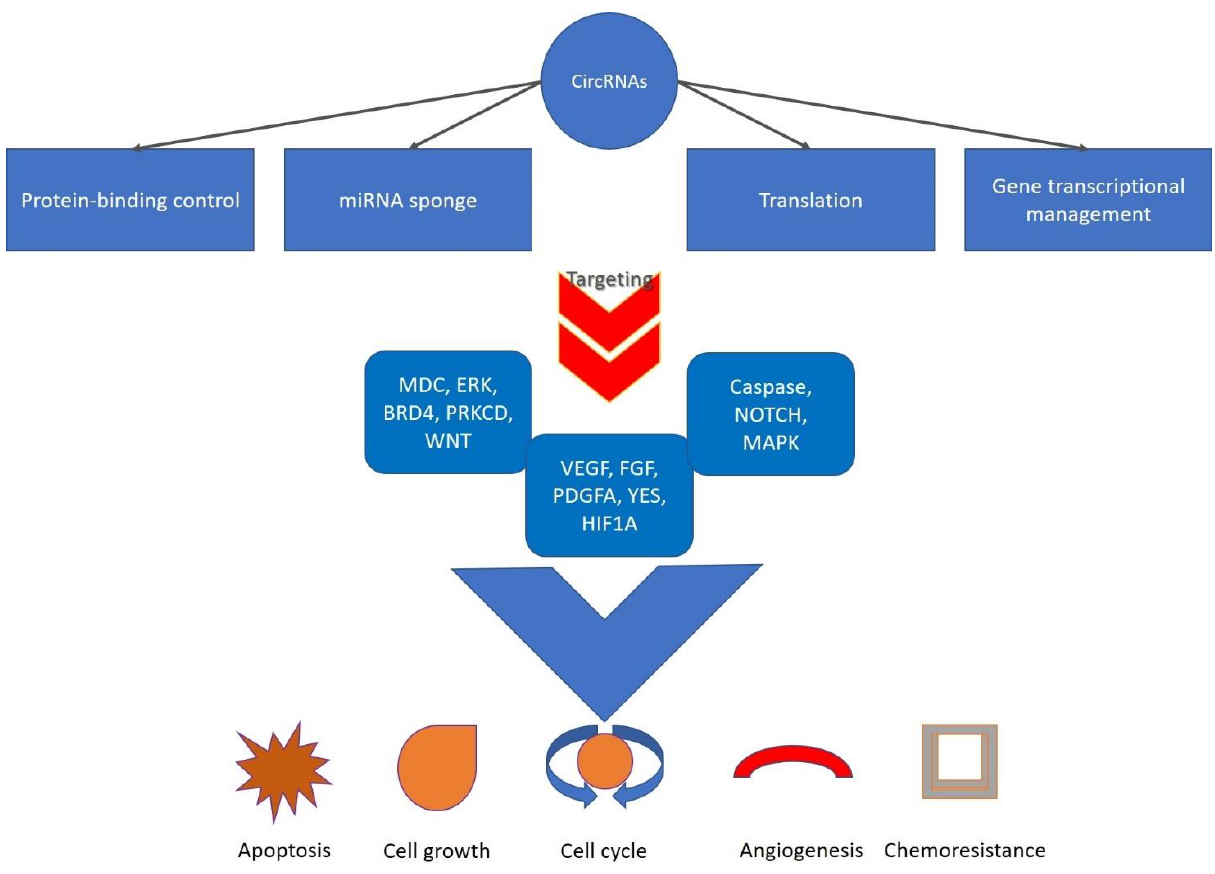
Figure 2. circRNAs carry out diverse biological actions by diverse mechanisms.